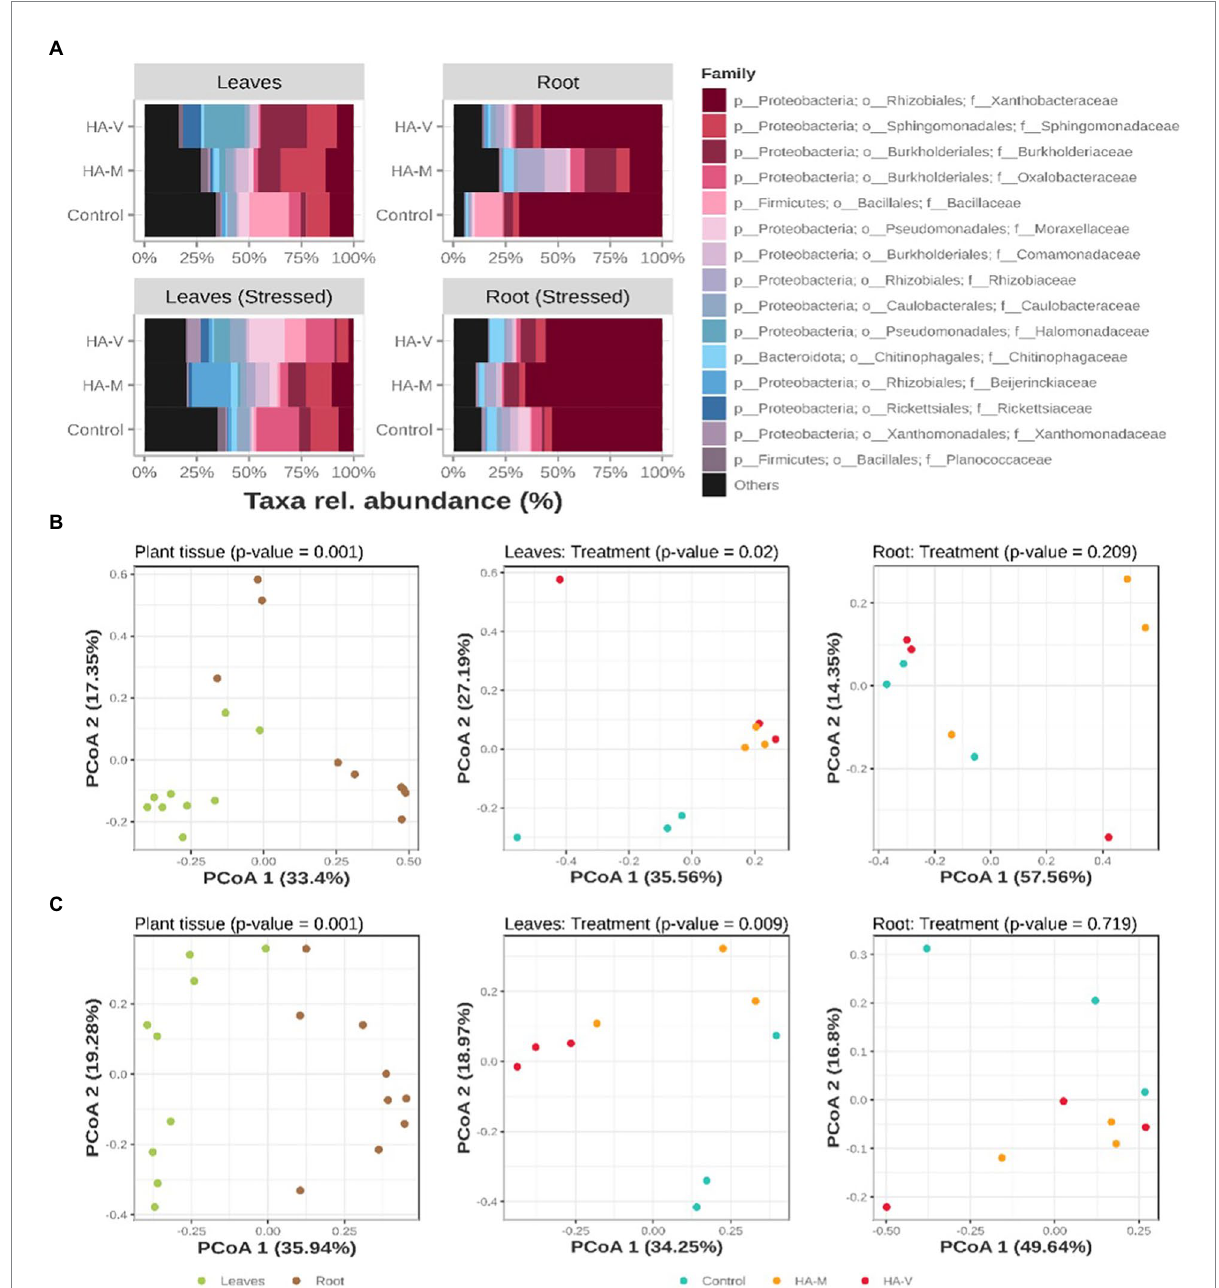
FIGURE 2 Relative abundances of the top 15 bacterial ASVs, collapsed to the taxonomic level of “family” (A) . Graphic representation of principal coordinate analysis (PCoA) based on the Bray–Curtis distances of samples in the absence (B) and presence (C) of stress. At the first level (on the left), the PCoAs of all samples tested in terms of separation by plant material are observed. Next (center and right), the distribution of leaf and root samples, respectively, tested according to the treatment received is observed. Treatments refer to the application of vermicompost HA (HA-V), millicompost HA (HA-M) and that did not receive application